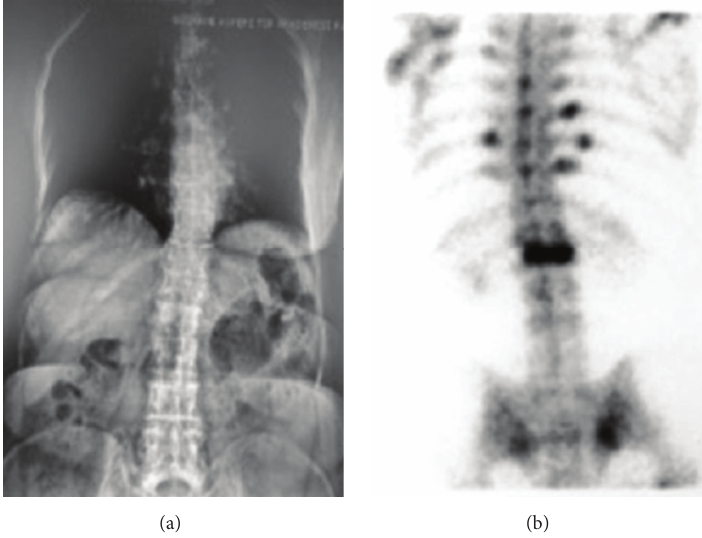
Figure 2: (a) Plane radiography and (b) scintigraphy showing L1 osteoporotic vertebra